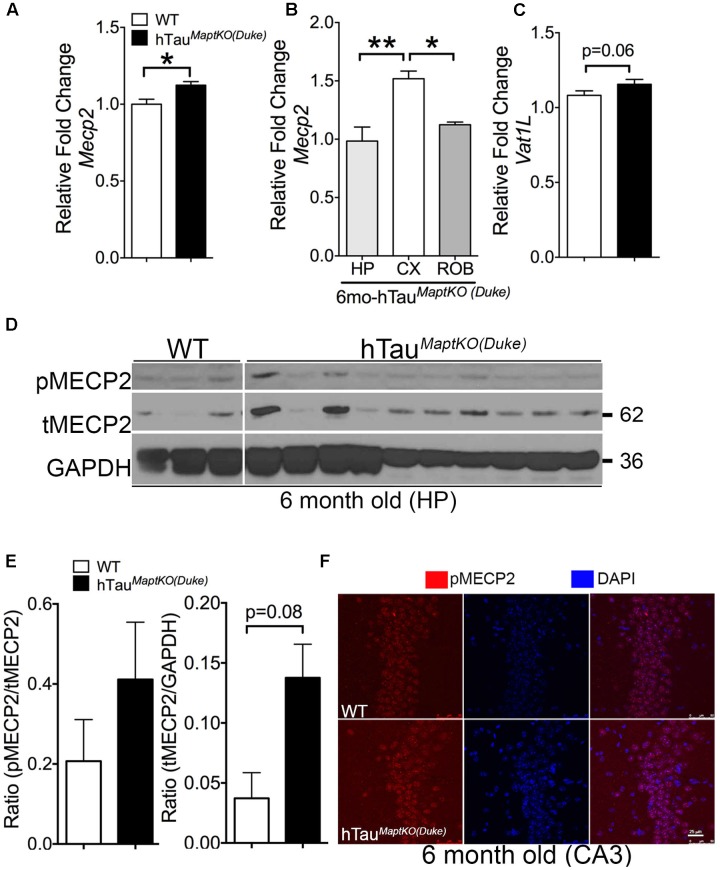
MECP2 expression and phosphorylation is up-regulated in 6-month-old hTauMaptKO(Duke) mice.
(A) qRT-PCR analysis showing statistically significant (∗p < 0.05; unpaired t-test; n = 4 WT, and n = 4 for hTauMaptKO(Duke) mice; mean + SEM) up-regulation of MECP2 in the hemi-brains of 6-month-old hTauMaptKO(Duke) vs. WT mice. (B) Note the regional differences in the expression of MECP2 in the hippocampus (HIP), cortex (CX), and rest of the brain (ROB) that are devoid of CX and HP. (C) Another gene (Vat1l) that was increased in our whole genome microarray analysis also showed modest up-regulation in its mRNA levels in the brains of hTauMaptKO(Duke) mice compared to age-matched WT mice. (D,E) Western blot analysis showing a trend toward increased levels for phospho(p)-Ser80 MECP2/total (t) MECP2 and tMECP2/GAPDH [p = 0.08; unpaired t-test; n = 3, all females for WT and n = 10, three females and six males for hTauMaptKO(Duke)] in 6-month-old hTauMaptKO(Duke) versus WT mice; mean + SEM). (F) Double IF and confocal microscopy analysis revealing a modest increase in pMECP2 in the CA3 region of HP in 6-month-old hTauMaptKO(Duke) mice compared to age-matched WT controls. Scale bar 25 μm.